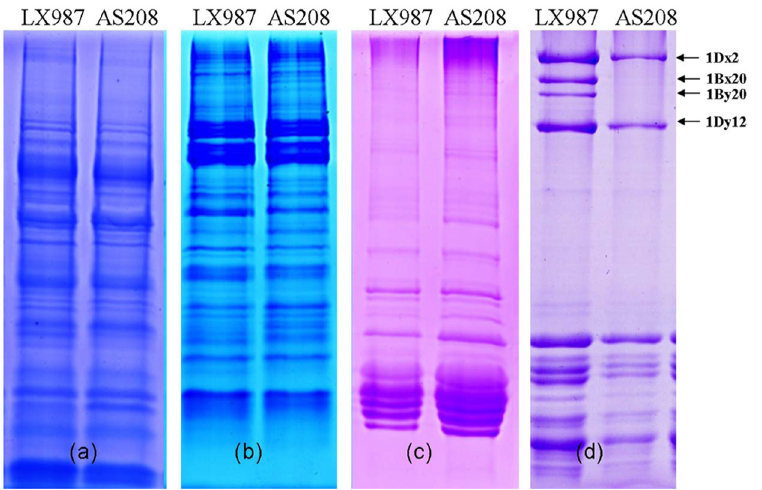
Fig 2. Identification of seed storage proteins in AS208 and LX987 by SDS-PAGE. The c ompositions for albumin (a), globulin (b), and gliadin (c) in AS208 were the same as those in its parental cultivar LX987, while the band patterns for glutenin (d) differed. The middle two HMW-GSs (1Bx20 and 1By20) were missing in the AS208 samples (d). The grains were harvested in Beijing in 2013.